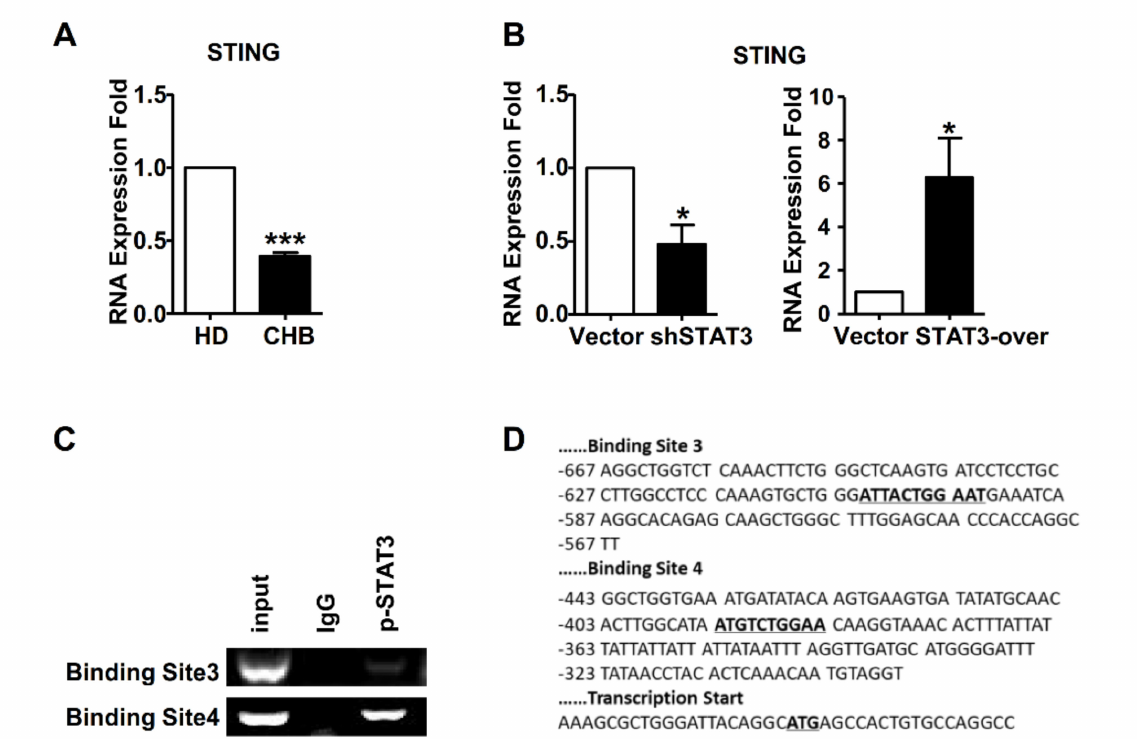
Figure 5. STAT3 regulated transcription of STING. ( A ) STING expression in NK cells isolated from HDs and CHB patients quantified by qPCR. ( B ) STING expression in STAT3-knockdown and -overexpressing NK-92 cells quantified by qPCR. ( C , D ) The predicted binding sites of STAT3 were verified by PCR on p-STAT3 antibody pull-down DNA of NK-92 cells, on the basis of JASPAR database analysis. Data are shown as mean ± SEM from three independent experiments. The statistically significant difference between two groups was determined by a t -test. * p < 0.05; *** p < 0.001. CHB, CHB patients; HD, healthy donors; Vector, LMP or pCDH; shSTAT3, STAT3-knockdown NK-92 cells; STAT3-over, STAT3-overexpression NK-92 cells; NK, natural